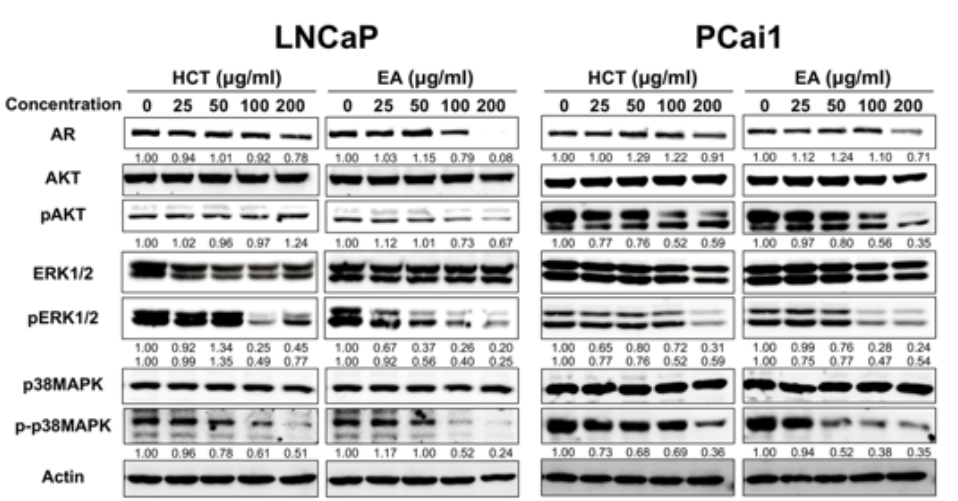
Figure 4. Western blot analysis of AKT, ERK, and MAPK pathways in HCT and EA-induced apoptosis of prostate cancer cells. The expression level of each protein expression in LNCaP and PCai1 cells treated with HCT and EA for 48 h and measured by western blotting. Whole un-cropped images see Figure S4. HCT, Houttuynia cordata Thunb.; EA, ethyl acetate fraction of H. cordata .